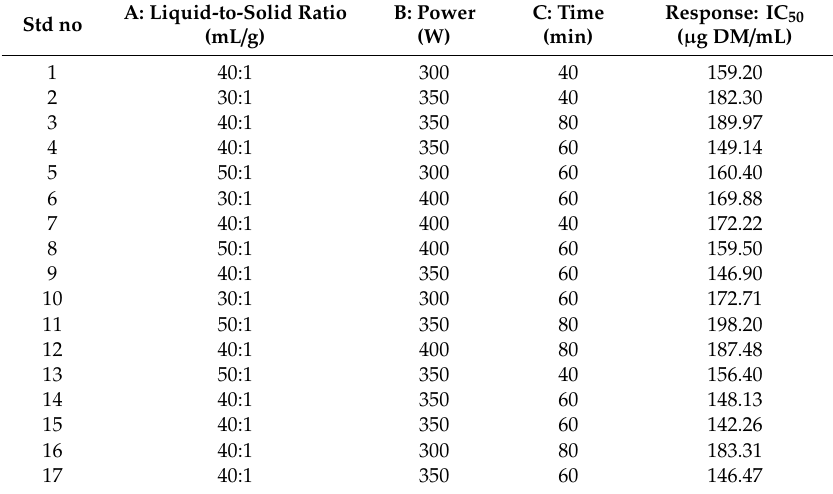
Table 2. ANOVA statistics for the α -glucosidase inhibitory activity of extracts. Source